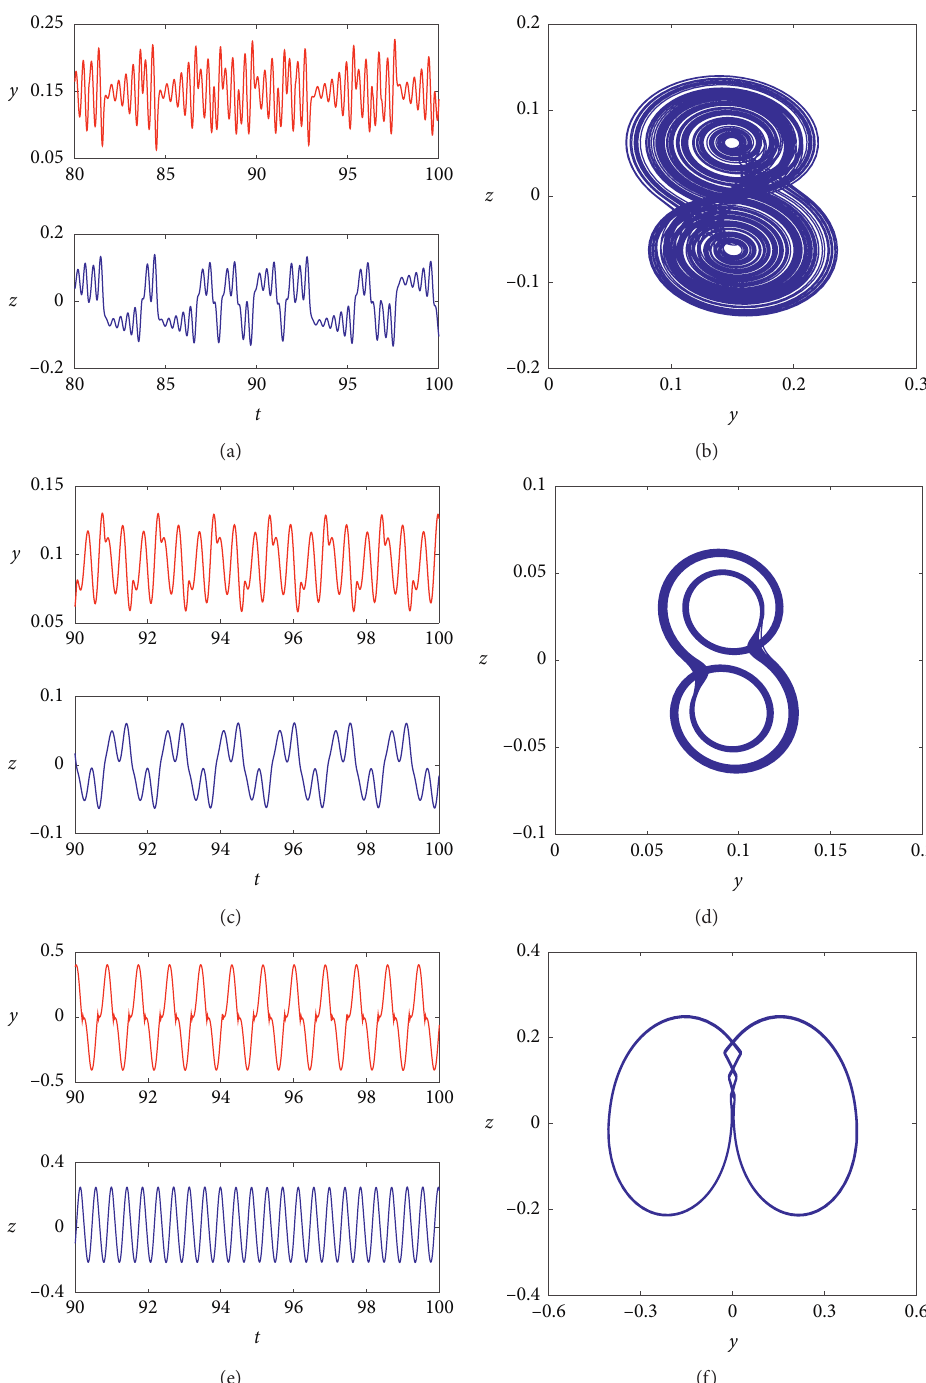
Figure 7: Different dynamics of the proposed chaotic system with respect to the initial condition being ( x and a � 112. For b � 2.4 and c � 16, (a) time-domain waveforms and (b) chaotic attractor. For b � 1.5 and c � 33, (c) time-domain waveforms and (d) quasi-periodic attractor. For b � 3 and c � 55, (e) time-domain waveforms and (f) periodic